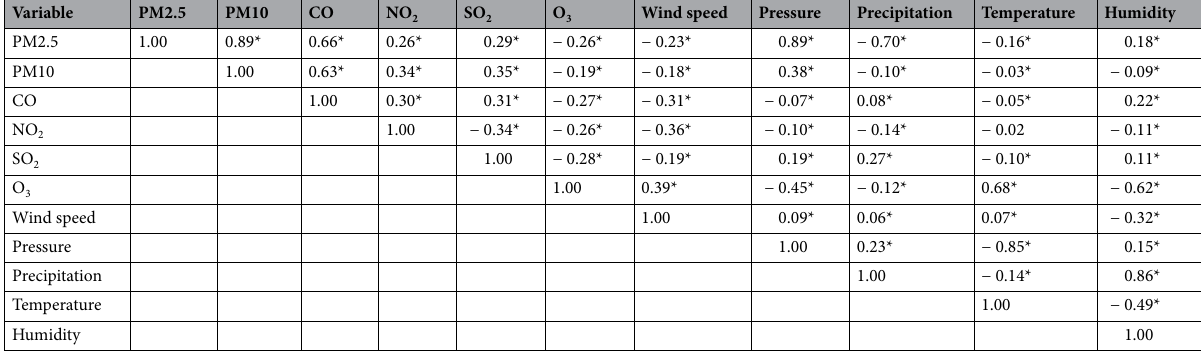
Table 2. Pearson linear correlation coefficients between six types of air pollutant concentrations and climate (Band * indicates significant correlation at a significant level of 0.05).